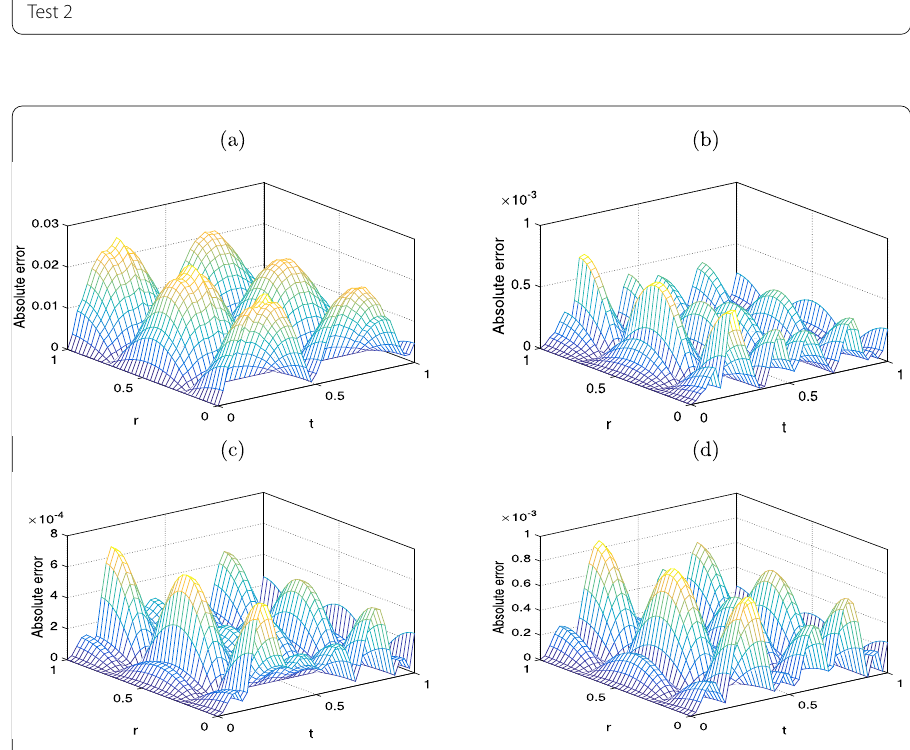
Figure 11 The absolute errors between the exact (37) and approximate z ( r , t ) with β : ( a ) 0, ( b ) 10 –11 , ( c ) 10 –10 , and ( d ) 10 –9 for p = 0.1%, for Test